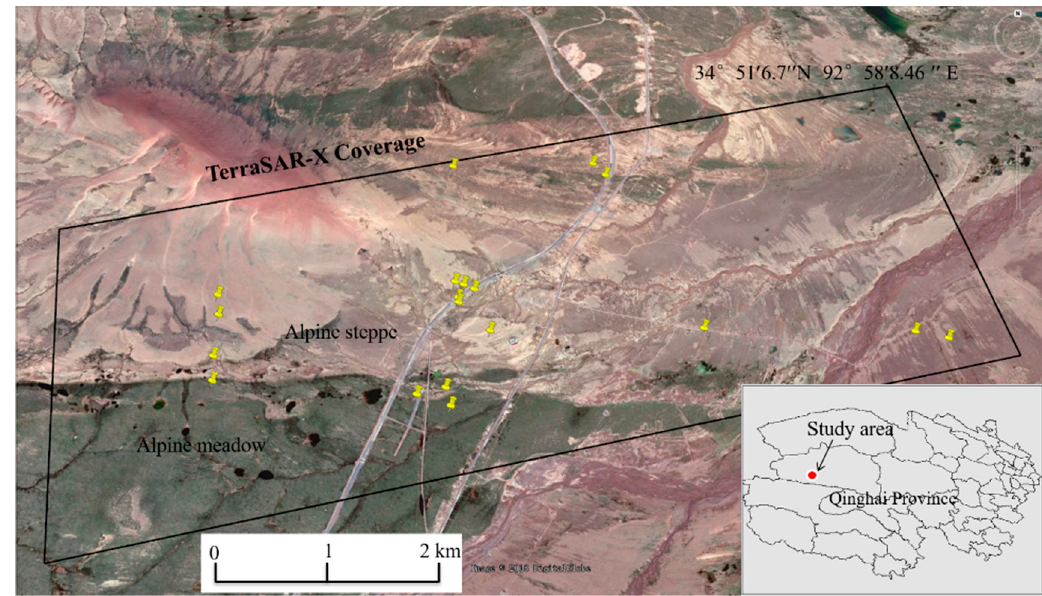
Figure 1. Map of the test site and the TerraSAR-X ST mode data coverage. Yellow pins are the measurement locations. Background is the Google map.